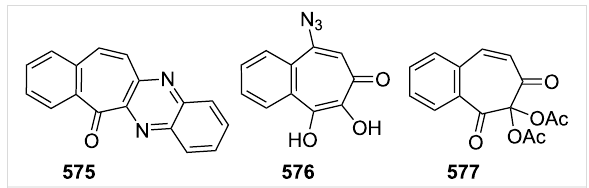
Figure 36: Products 575–577 through 1,2,3-benzotropoquinone hydrate 569